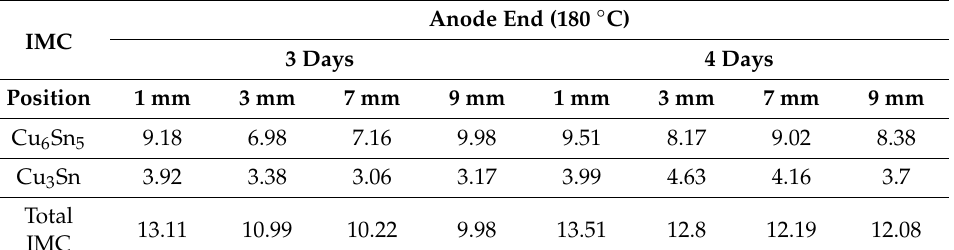
Table 7. The IMC formation and their corresponding thickness in the anode end of the sample heated at 180 °C and subjected to a current of 0.8 A.